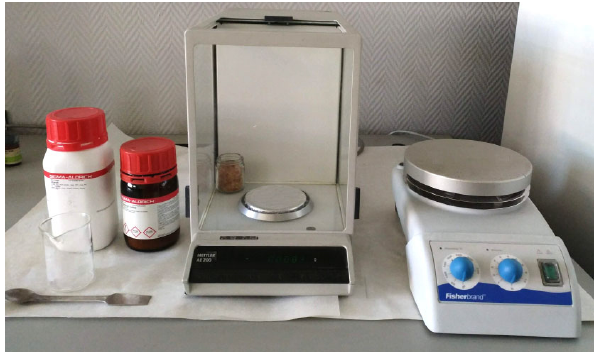
Figure 4. Instrumentation and materials (potassium iodide, starch, rods, beakers, balance, and